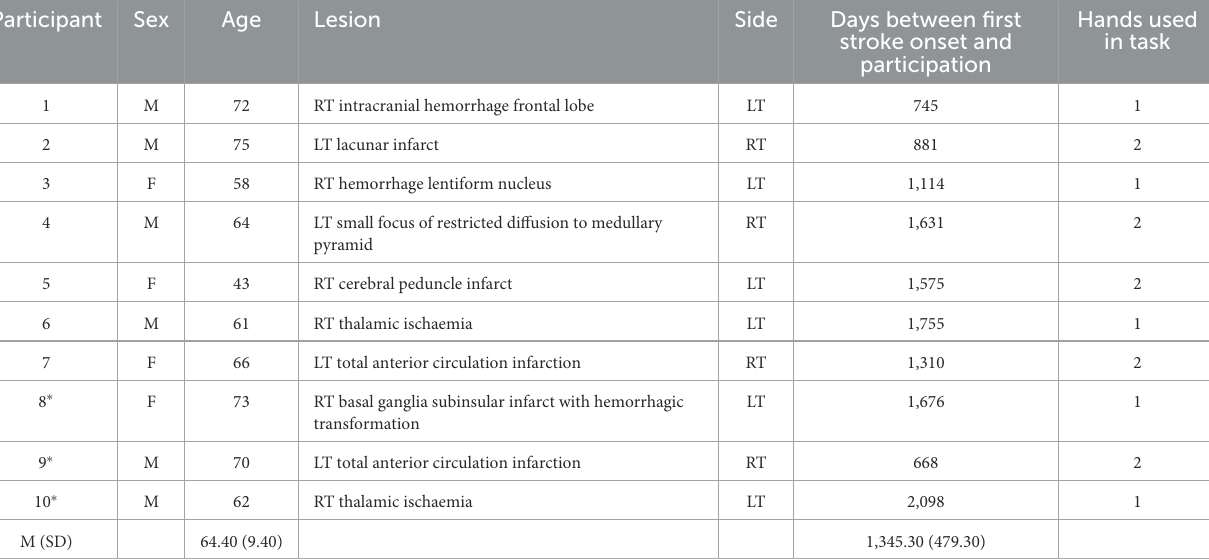
TABLE 1 Stroke demographic information.